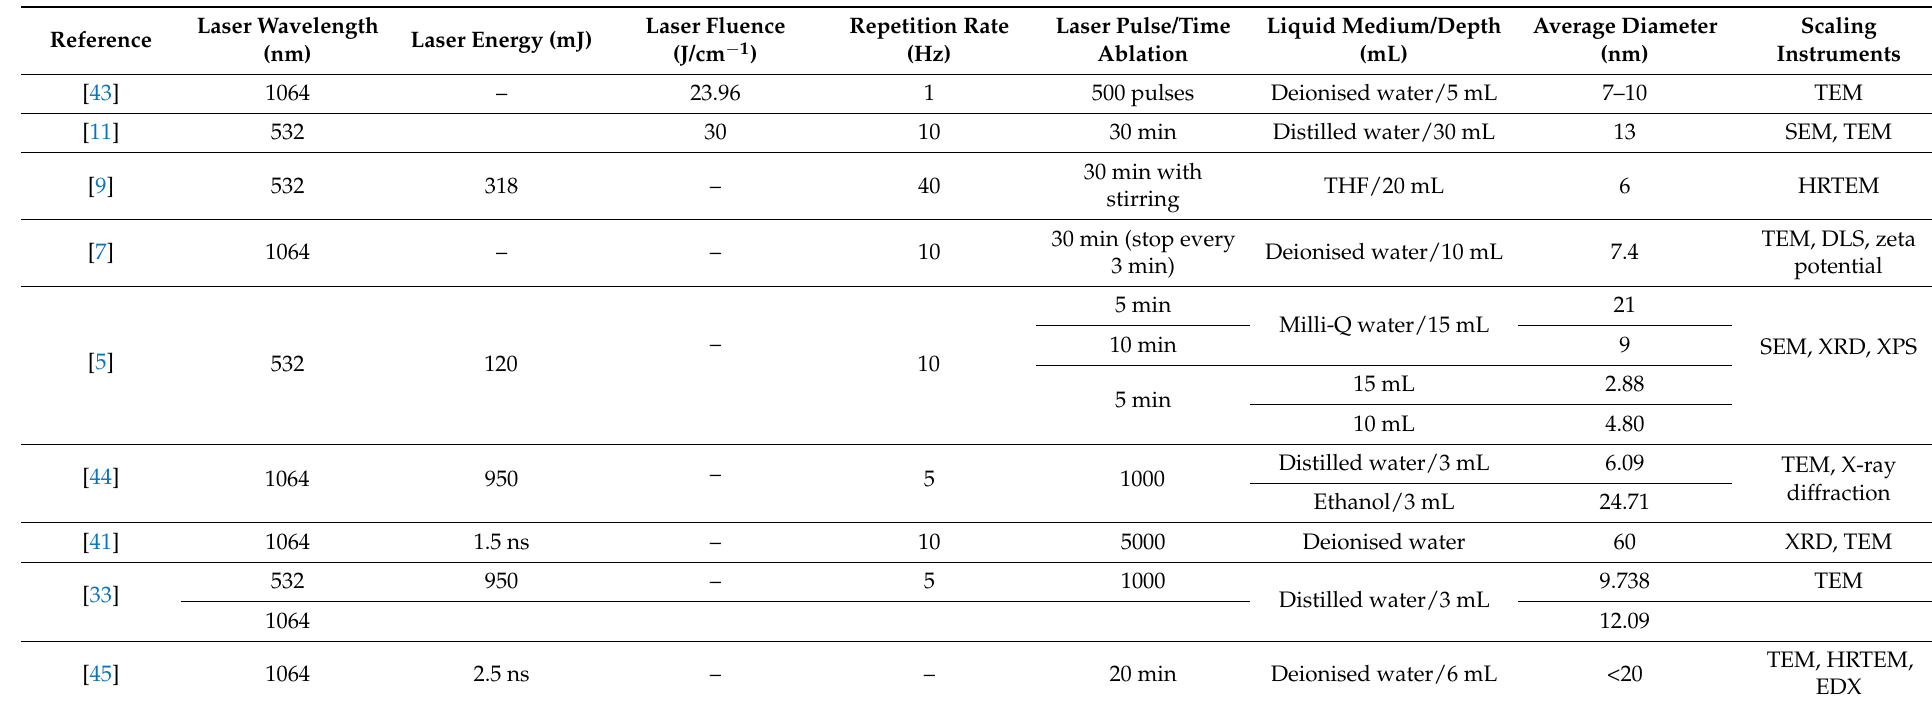
Table 5. A summary of the effect of laser parameters selection on diameter of gold